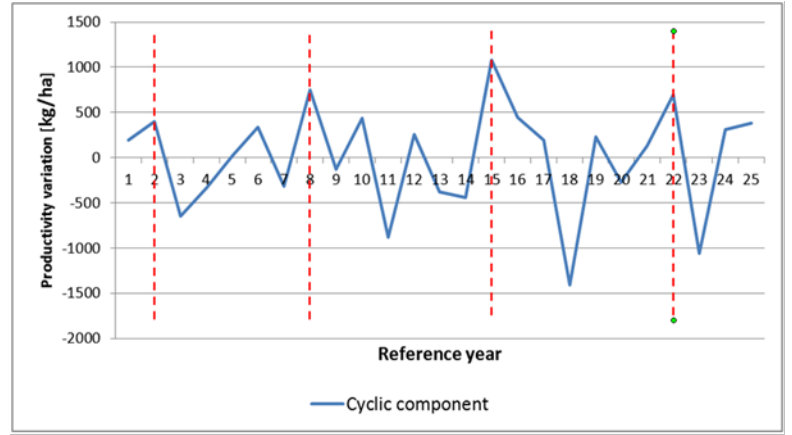
Figure 6. The cyclical component of cereals series. Source: authors own computation based on [56].